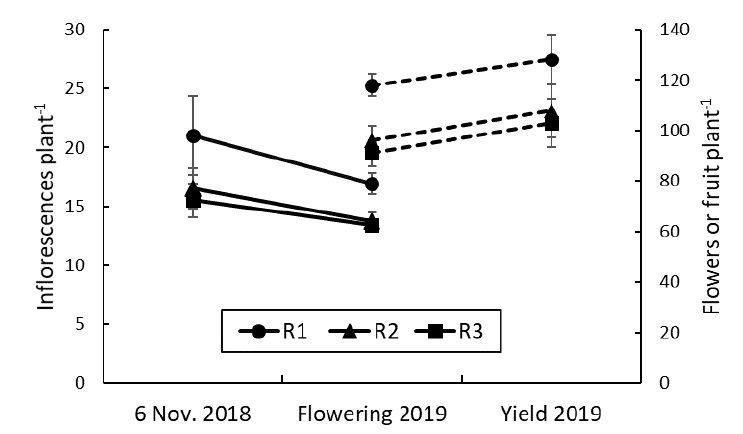
Fig. 3. Number of inflorescence initials (solid line) observed through flower mapping on 6 November 2018 (development stages 5 to 8) and during flowering in 2019, and the number of flowers and fruit (dotted line) per plant in strawberry cv. Polka in different runner removal treatments. R1 = runners removed three times; 25 July, 15 August, and 4 September 2018, R2 = runners removed on 10 September 2018, R3 = no runner removal. Vertical bars represent ± SEM, n =